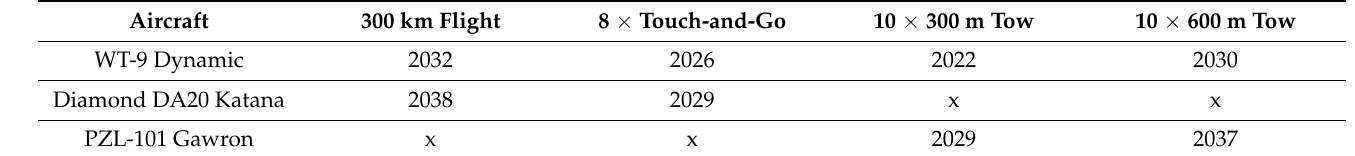
Table 11. Anticipated dates for achieving the minimum requirements for electric aircraft of different